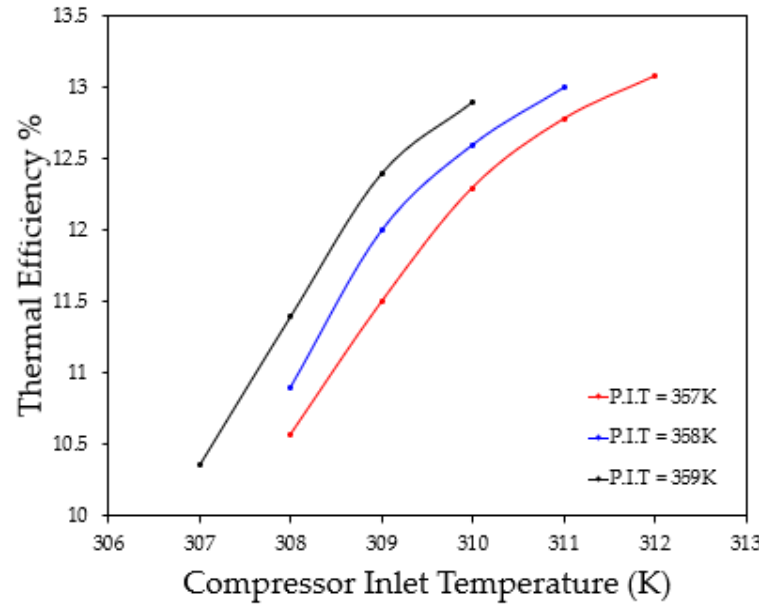
Figure 11. Cycle thermal efficiency analysis.